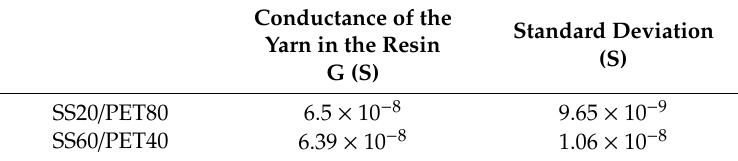
Table 6. Principle of the short circuit of the SS20 / PET80 and SS60 / PET40 yarns in the resin. Conductance of